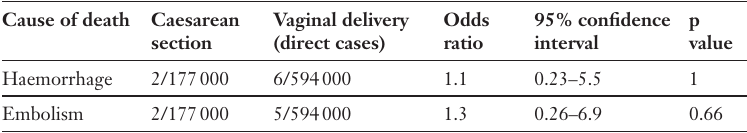
Cause of death in relation to caesarean section (causal relationship possible); vaginal deliveries = 77% of 771206 births. Cause of death Caesarean